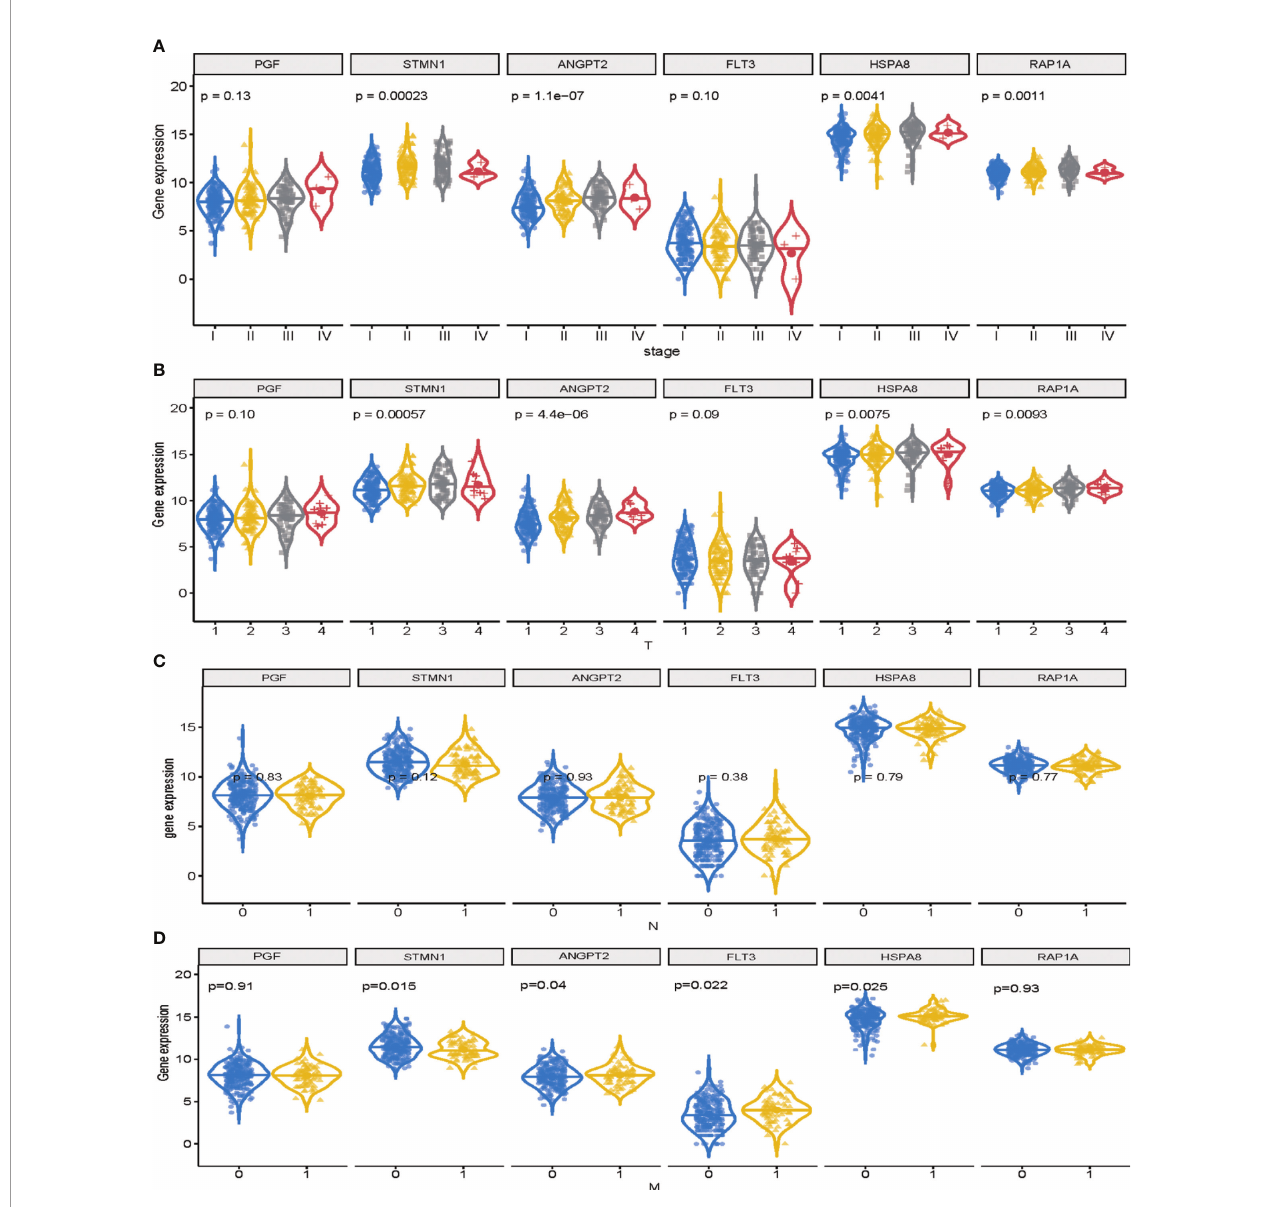
FIGURE 4 | Validation of signature genes in the MAPK-RAP1A dataset. (A) Expression of STMN1, FLT3, ANGPT2, HSPA8, RAP1A, and PGF in HCC samples with different TNM stages. (B) Expression of STMN1, FLT3, ANGPT2, HSPA8, RAP1A, and PGF in HCC samples with different T stages. (C) Expression of STMN1, FLT3, ANGPT2, HSPA8, RAP1A, and PGF in HCC samples with different N stages. (D) Expression of STMN1, FLT3, ANGPT2, HSPA8, RAP1A, and PGF in HCC samples with different M